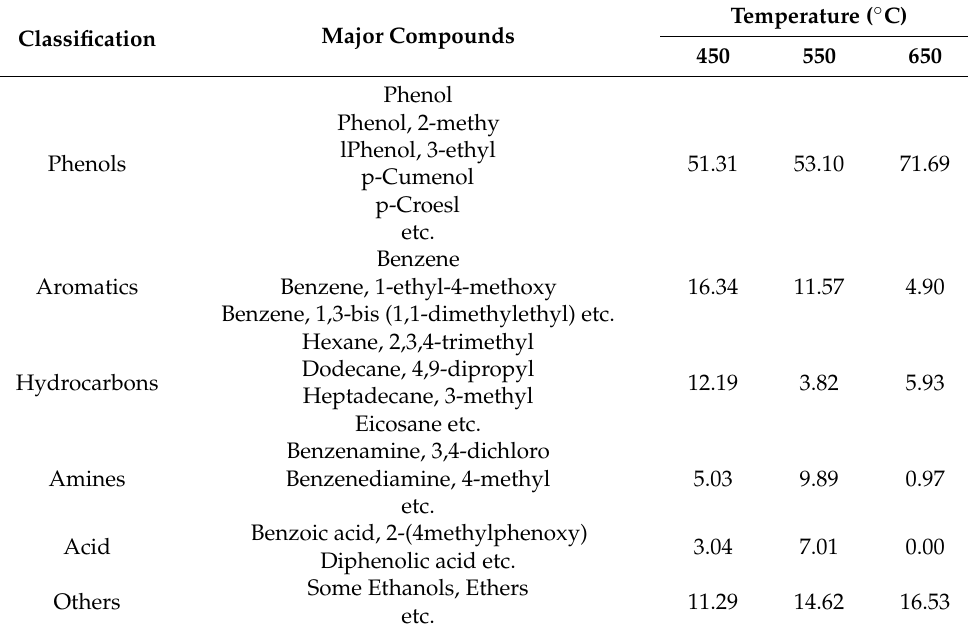
Table 7. The liquid product composition (wt.%) from microwave pyrolysis of CF/EP prepreg.